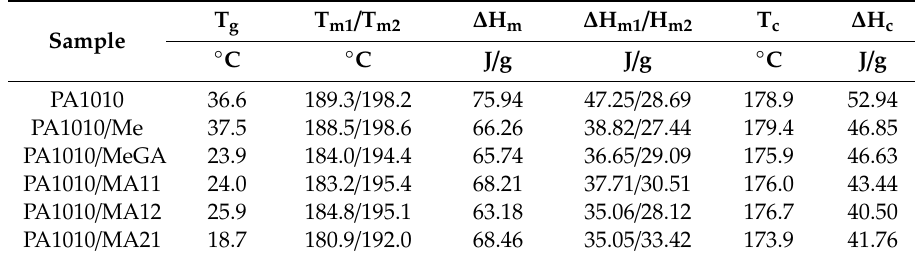
Table 5. Main thermal properties obtained from the DSC curves in terms of glass transition temperature (T g ), melting temperature (T m ), normalized enthalpy of melting ( ∆ H m ), crystallization temperature (T c ), and normalized enthalpy of crystallization ( ∆ H c ).